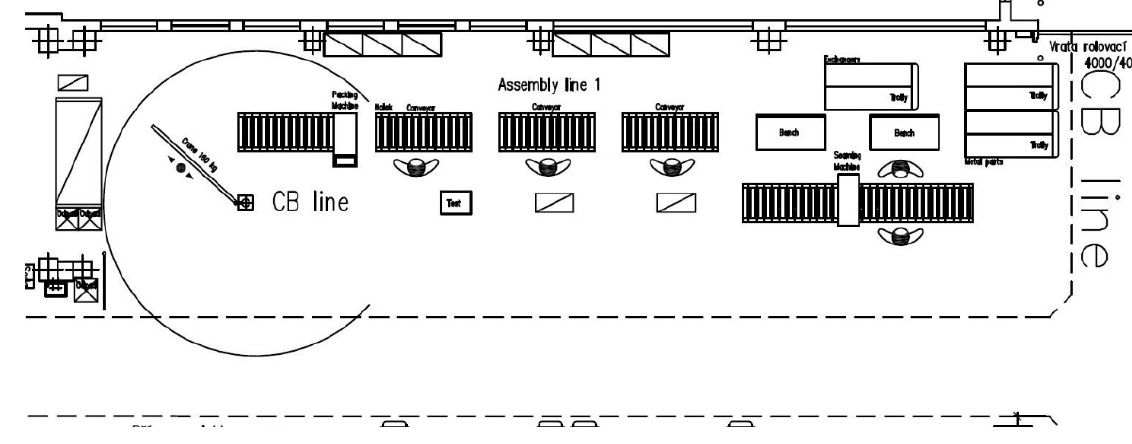
Figure 5. Layout of the assembly line.